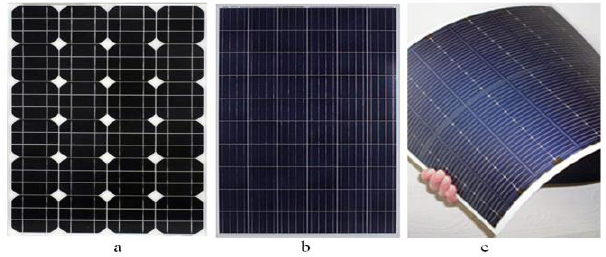
Fig. 1. Silicon PV panels: а – monocrystalline; b – polycrystalline; c –